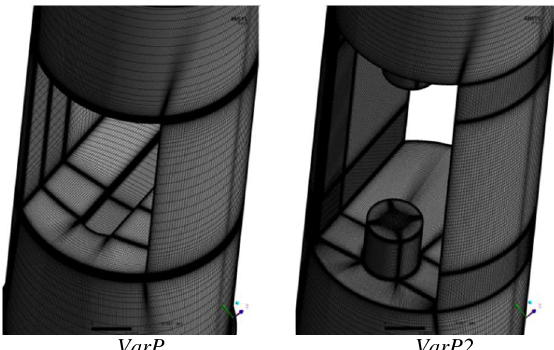
Fig. 3 . Computation model of the variant with the extinction probe .